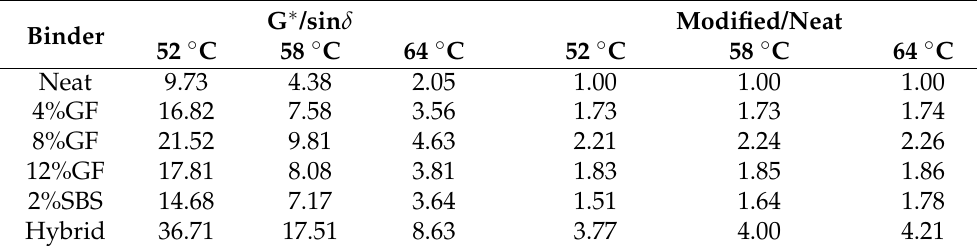
Table 7. Temperature’s effect on the rutting factors of neat and modified asphalt binders at 10 rad/s. G ∗ /sin δ Binder